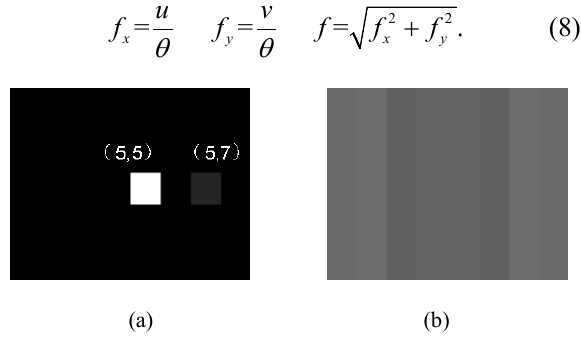
Fig. 2 Schematic diagram to reflect the relationship between the DCT forward transformation and inverse transformation: (a) two points with the coordinates of (5, 5) and (5, 7) saved in the DCT domain of “Lena” image and (b) the stripes obtained by the inverse